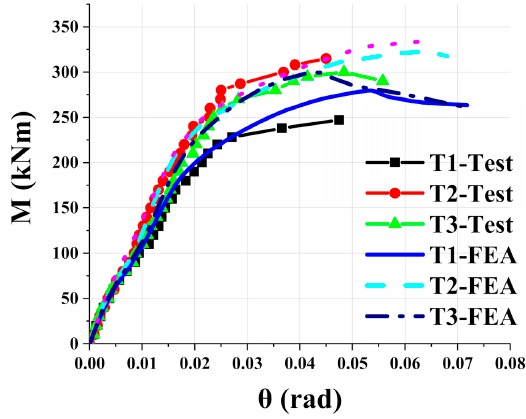
Figure 5. Validation of finite element